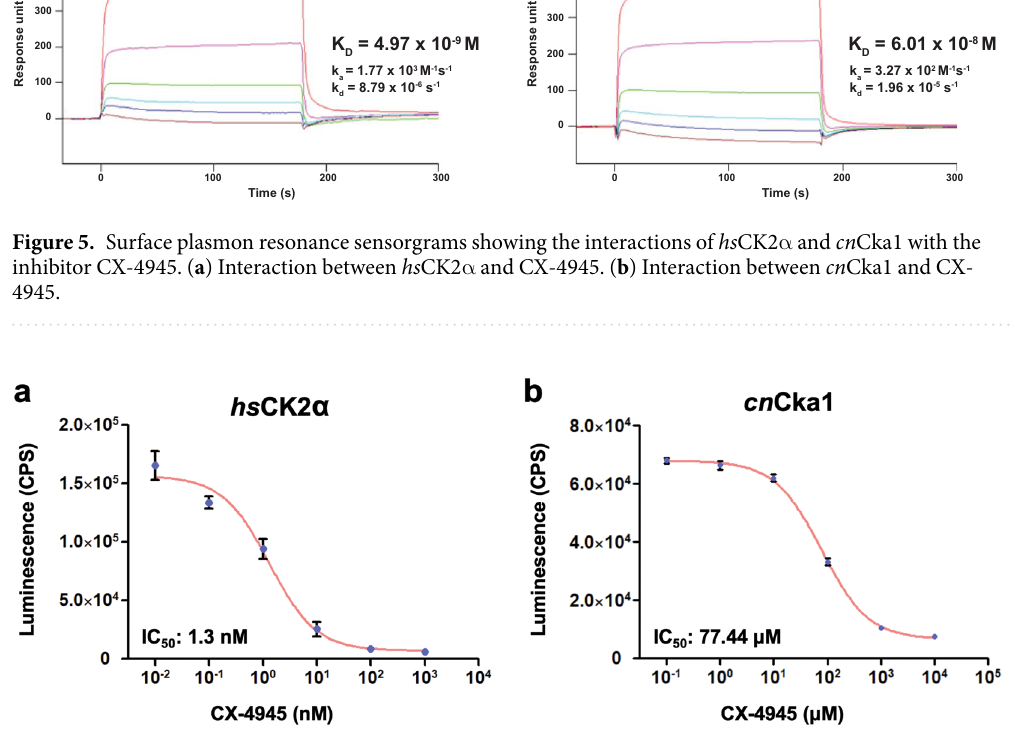
4.97 nM (Fig. 5a, Supplementary Table S2), while the K D value of cn Cka1 was revealed to be 60.1 nM (Fig. 5b, Supplementary Table S2). Our results indicate that CX-4945 binds to cn Cka1 at a binding affinity about twelve